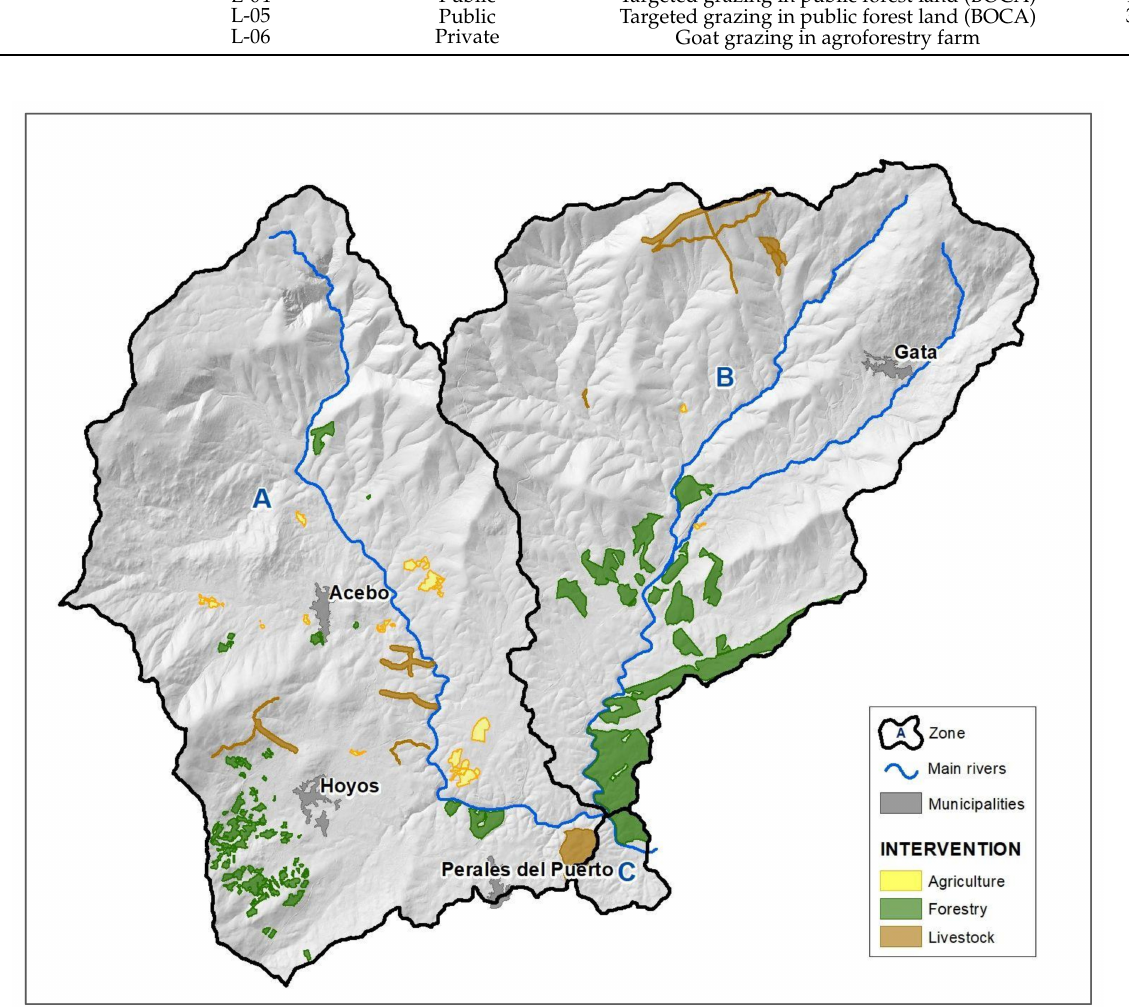
Figure 2. Overview of interventions at the study